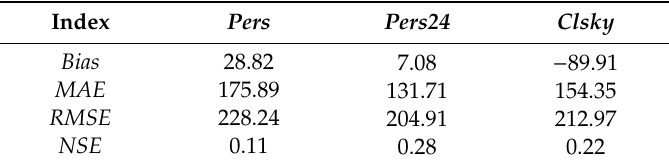
Table 2. Average performances of the Pers , Pers24 , and Clsky predictors on the first 3 hours (daytime samples only).